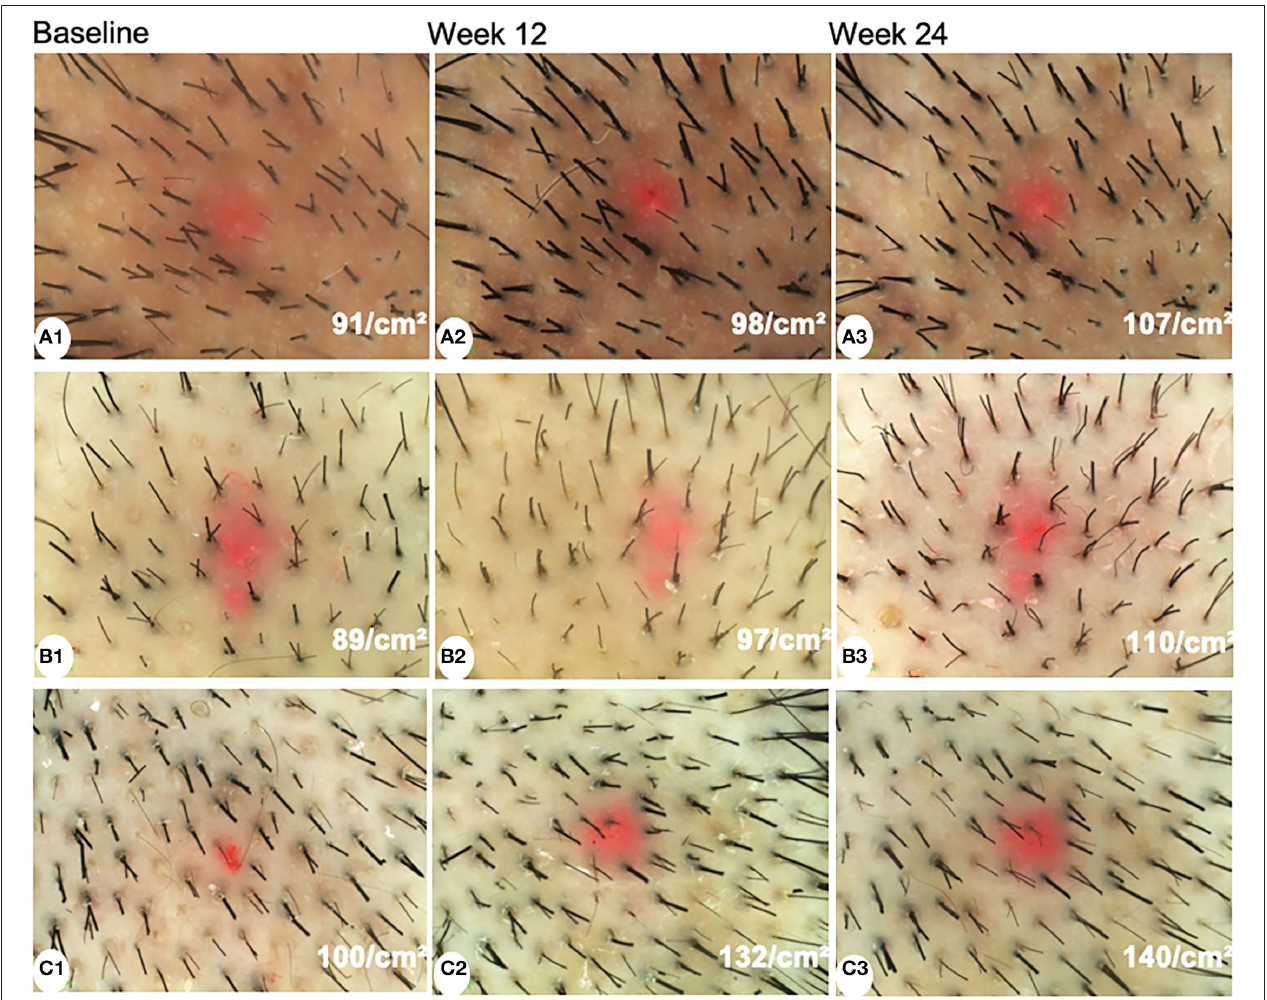
FIGURE 2 | Dermoscopic images of patients treated with minoxidil (A) , minoxidil plus spironolactone (B) , and minoxidil plus microneedling (C) at baseline, week 12, and week 24 (magnification: 20 ×